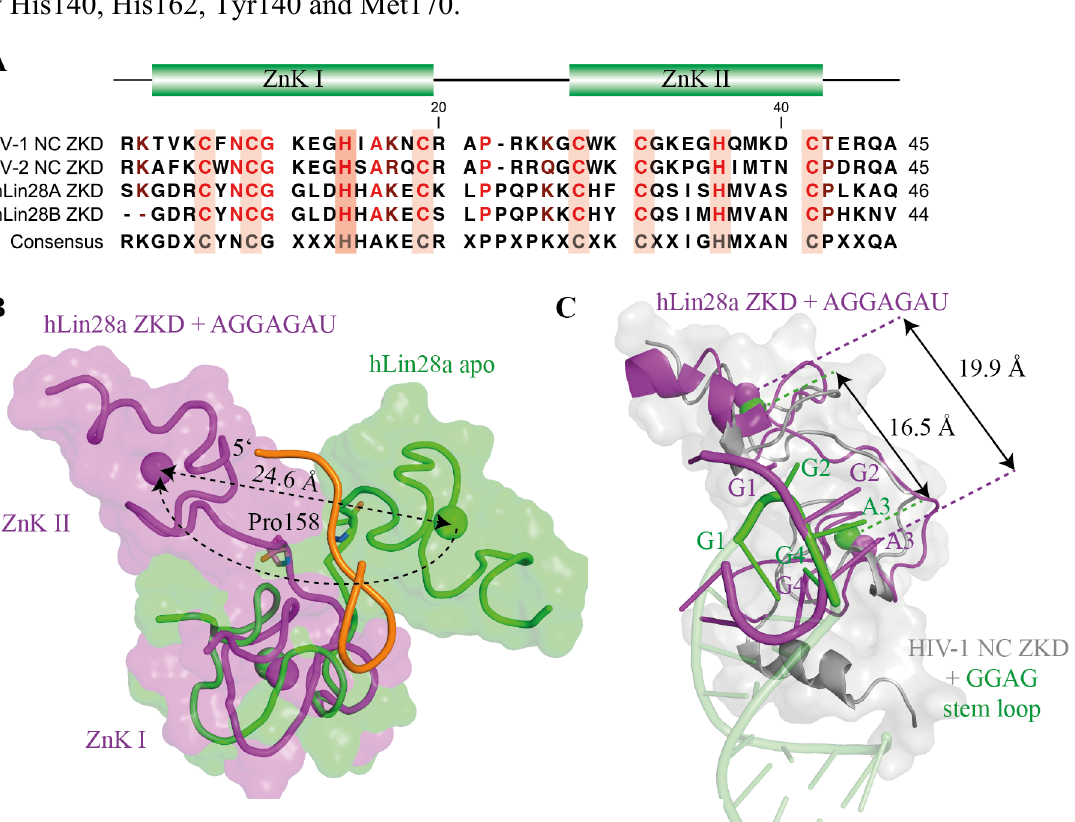
Figure 5. Lin28 ZKD specifically recognizes single-stranded GGAG or GGAG-like sequences. ( A ) Sequence alignment of HIV-1 NC, HIV-2 NC, hLin28a and hLin28b ZKDs. The chelating Cys and His residues of the CCHC Zn knuckles (ZnK) are shaded in red. Conserved residues are labeled from light red (100% type-conserved) to dark red (70% type-conserved); ( B ) Comparison between unbound hLin28a ZKD (green, PDB-ID 2CQF) and AGGAGAU-bound hLin28a ZKD (purple, PDB-ID 2LI8). Upon RNA binding, hLin28a ZKD undergoes a dramatic conformational shift mainly caused by a rotation of the Pro158 ψ angle; ( C ) In comparison to HIV-1 NC, the inter-knuckle linker of hLin28a ZKD harbors an additional Pro. As a consequence, the knuckles are further apart, thereby explaining why HIV-1 NC ZKD specifically binds G-2 and G-4 while hLin28a ZKD binds G-1 and G-4 of the GGAG motif in a hydrophobic pocket; ( D ) Structure of mLin28a ZKD bound to GGAG (derived from PDB-ID 3TSO). mLin28a is represented in green cartoon and the bound GGAG motif in purple (G) and pink (A). Tyr140 of the first and His162 of the second ZnK are key residues for the interaction, since they contact each other and stack with the bases, thereby establishing a kinked conformation in the RNA. All three guanosines are specifically recognized via various hydrogen bonds with backbone amide and carbonyl groups. In addition, G-1 and G-4 are bound in a hydrophobic pocket formed by His140, His162, Tyr140 and